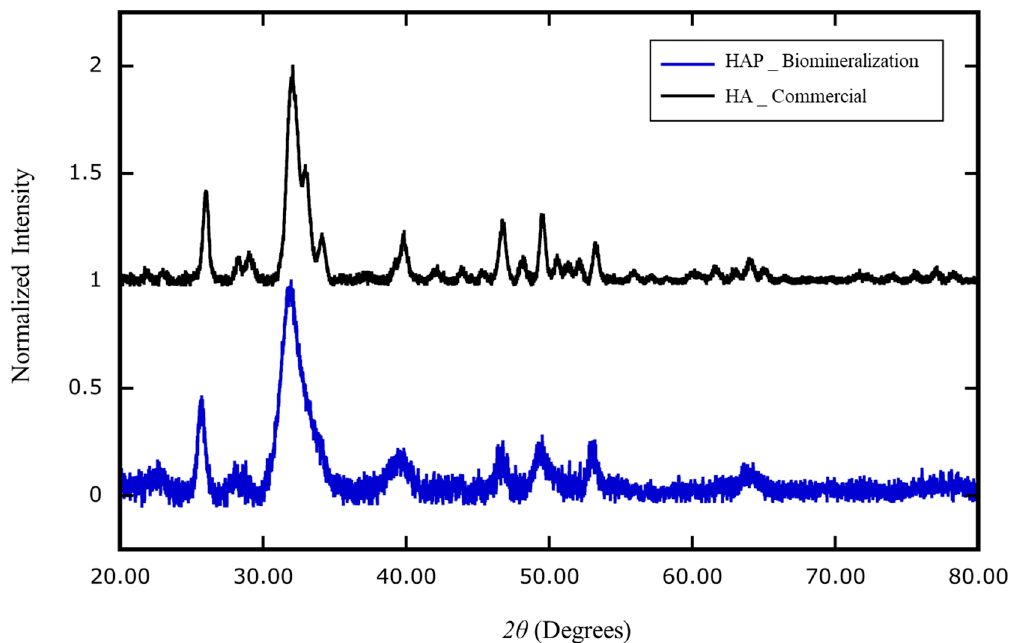
Figure 6. X-ray diffraction analysis of the composition of nanoparticles generated by cell biomineralization versus industrial production. The mineral extracted from human blood mononuclear cells (HAP _ Biomineralization) cultured in MEM α / 10% FBS supplemented with α GP (2 mM) and CIP (1 U / mL) for 7 days was identified as homogeneous hydroxyapatite (HAP) (Ca 10 (PO 4 ) 6 (OH) 2 , blue). The industrial product of recovered bony material was identified as heterogeneous calcium-phosphate hydrate (Ca 3 (PO 4 ) 2 · xH 2 O) (HA _ Commercial; black).